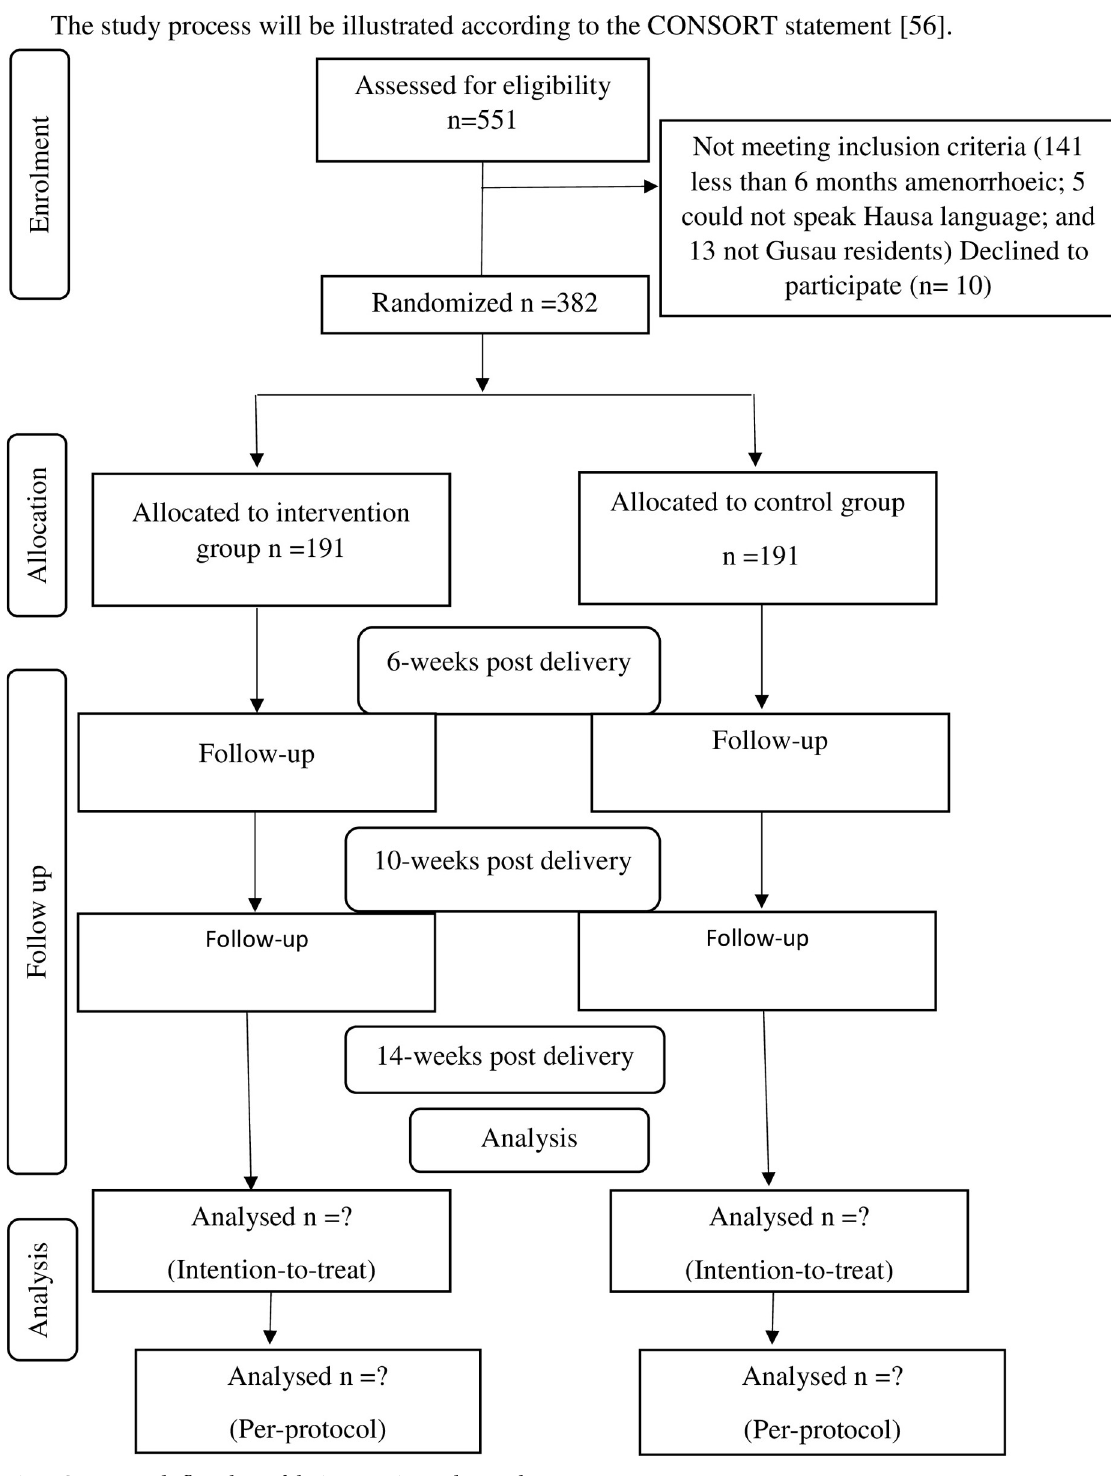
Fig 2. Consort study flow chart of the intervention and control groups.